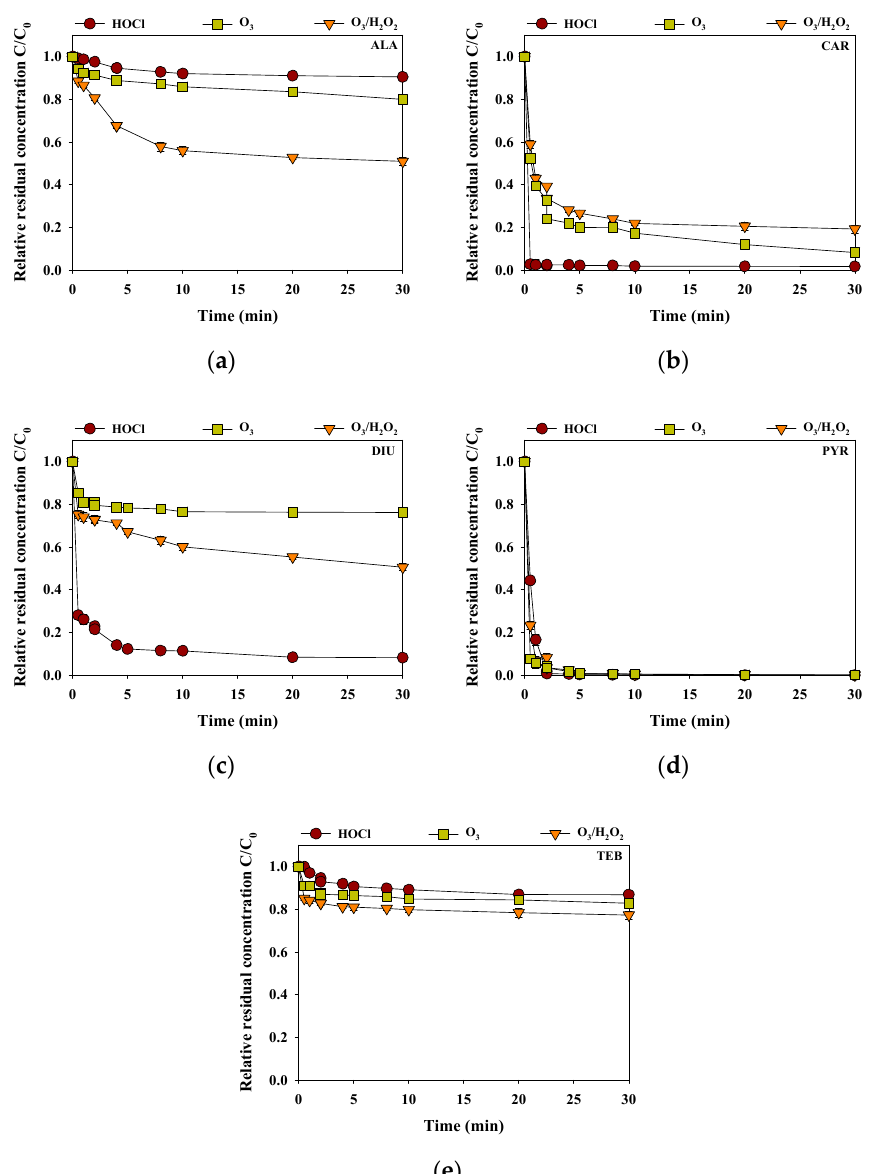
Figure 4. Removal efficiencies of ( a ) ALA, ( b ) CAR, ( c ) DIU, ( d ) PYR and ( e ) TEB by HOCl, O 3 , and O 3 /H 2 O 2 in the rainwater (initial concentration of each pesticide = 2 μ M, reaction time = 0.5 h, temperature = 25 °C, pH = 6.6).